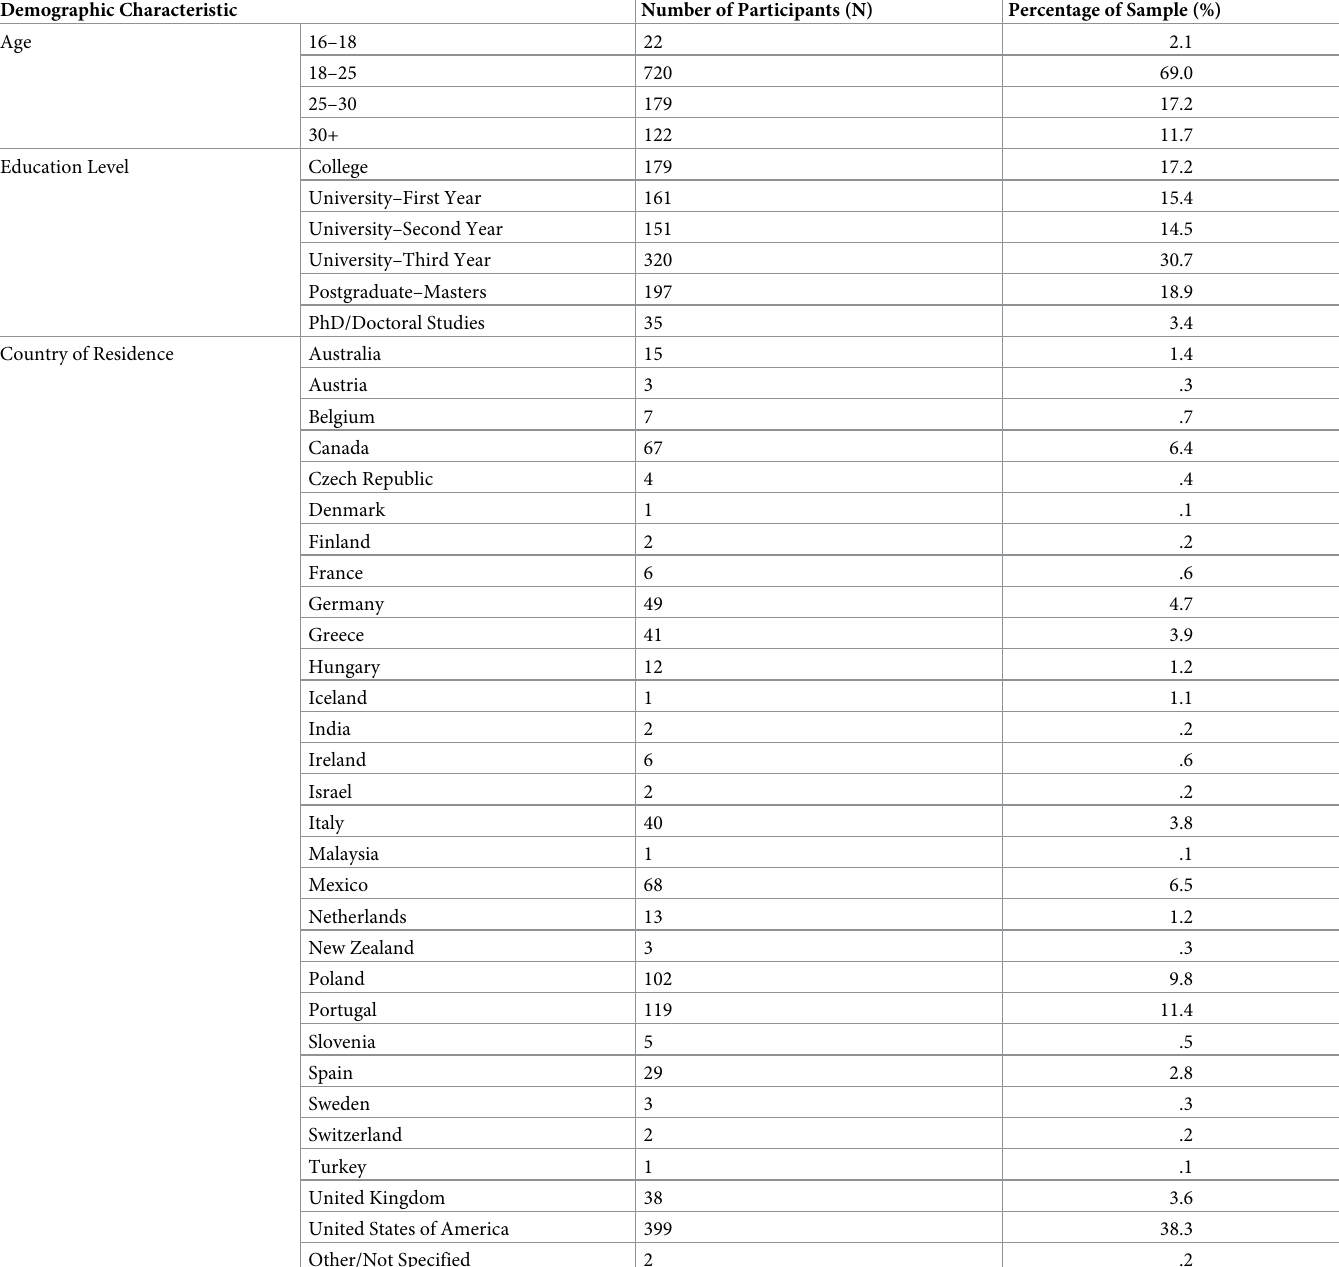
Table 1. Demographic characteristics of the participant